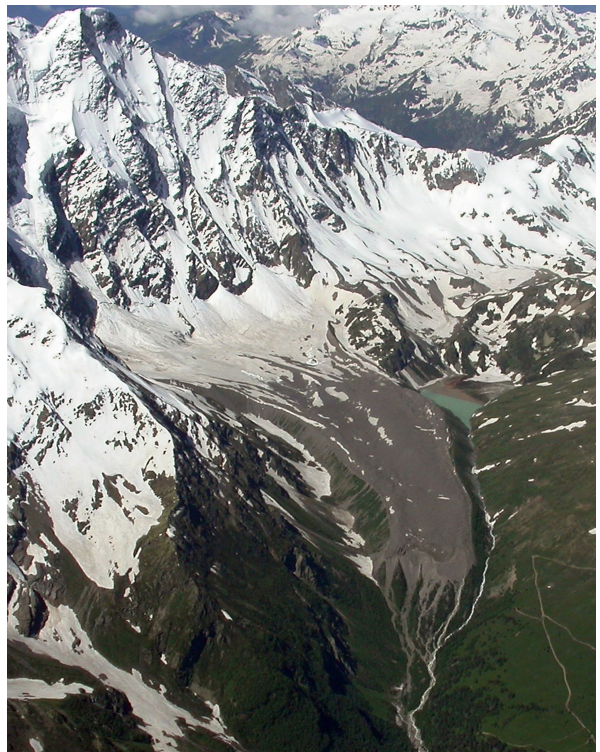
Figure 3. Oblique aerial photograph of the Donguz-Orun glacier which has the highest extent of debris cover in the sample. Photo- graph by I. I. Lavrentiev (25 August